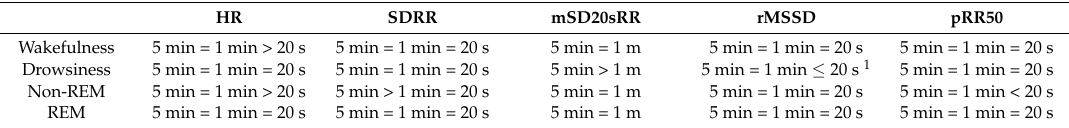
Table 1. Summary of results comparing the different sampling intervals from the longest occurrence of all sleep stages. The direction of significant differences are indicated with inequality signs (>,